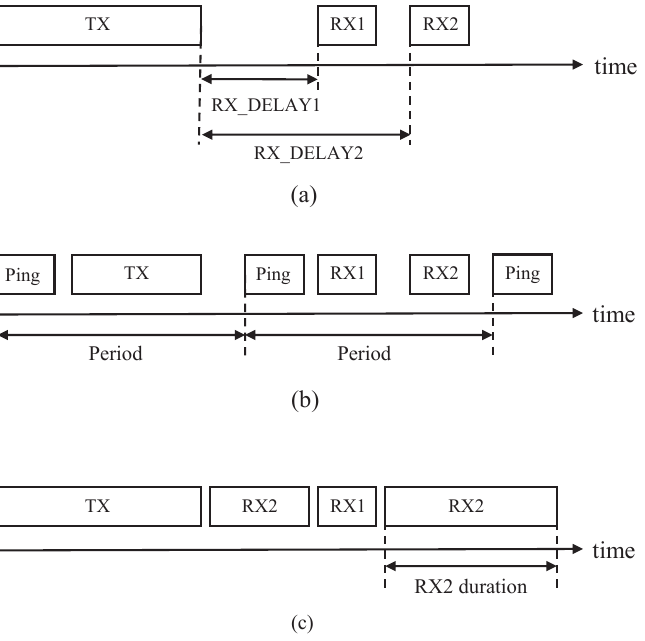
Figure 1. Transmission and reception slot timing of the end device in LoRaWAN. ( a ) Class-A. ( b ) Class-B. ( c )